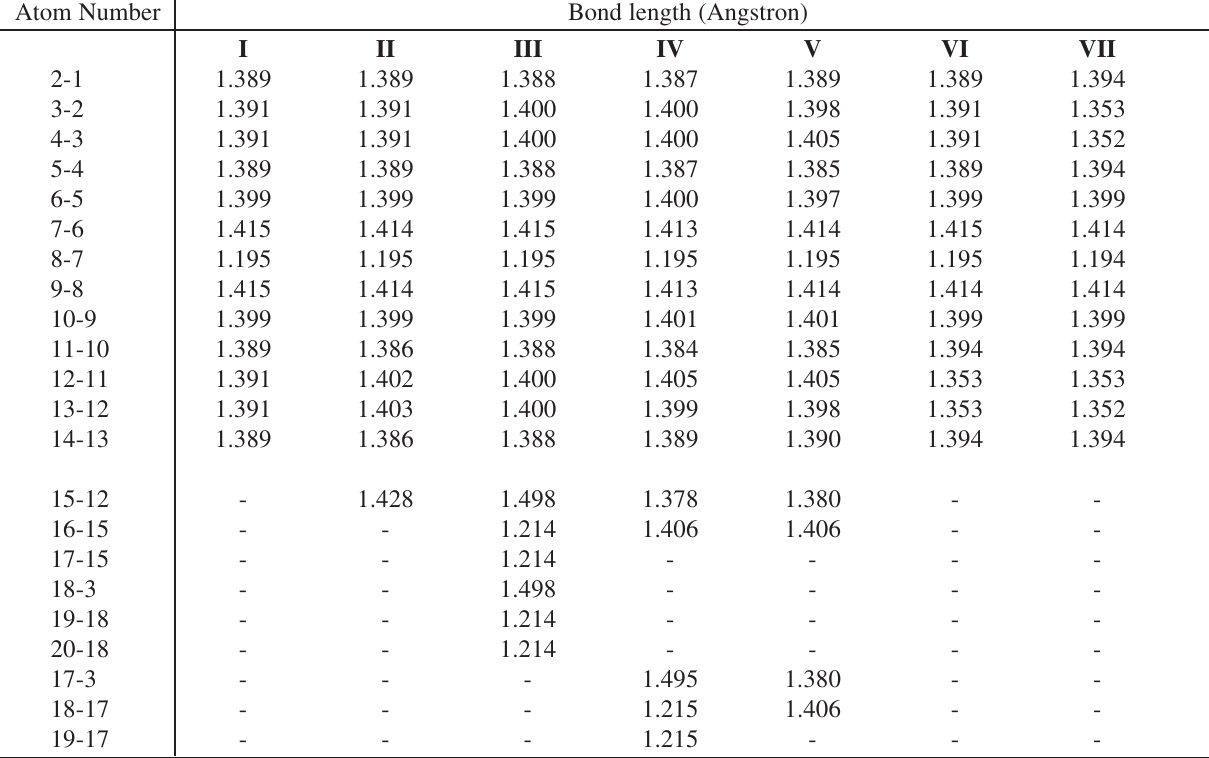
Table 4. Bond Length (Angstrons) of the alkynes molecules described by Table 1. Atom